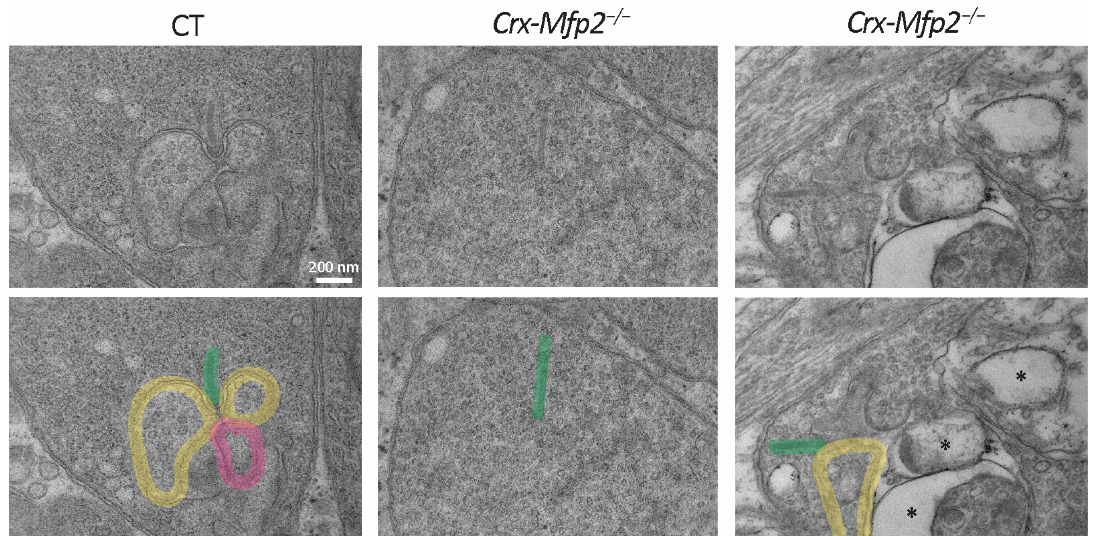
Figure 6. Loss of photoreceptor ribbon synapse integrity in 6-month-old Crx-Mfp2 − / − mice. Trans- mission electron microscopy images showed normal photoreceptor ribbon synapse formation in CT mice, with a ribbon (green), two horizontal cells (yellow) and a bipolar cell (pink). Crx-Mfp2 − / − mice presented with free-floating photoreceptor ribbons and abnormal structures (*) in the photoreceptor synapses, which did not occur in CT mice. Top and bottom panel are the same images. Bottom panel includes interpretation. N = 4/group.